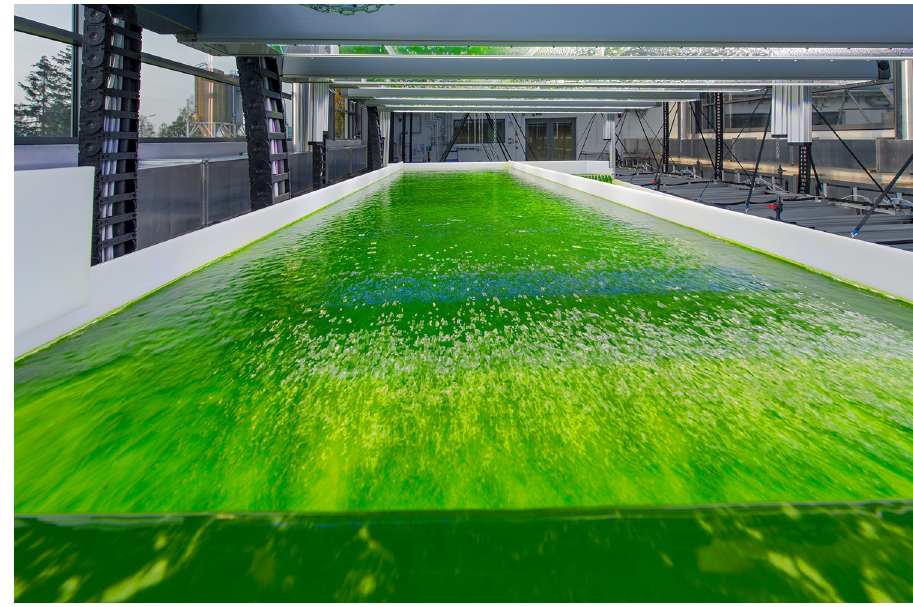
Fig 2. Algae cultivation at the AlgaeTec. This image showcases the open algae cultivation systems located at Technical University of Munich,